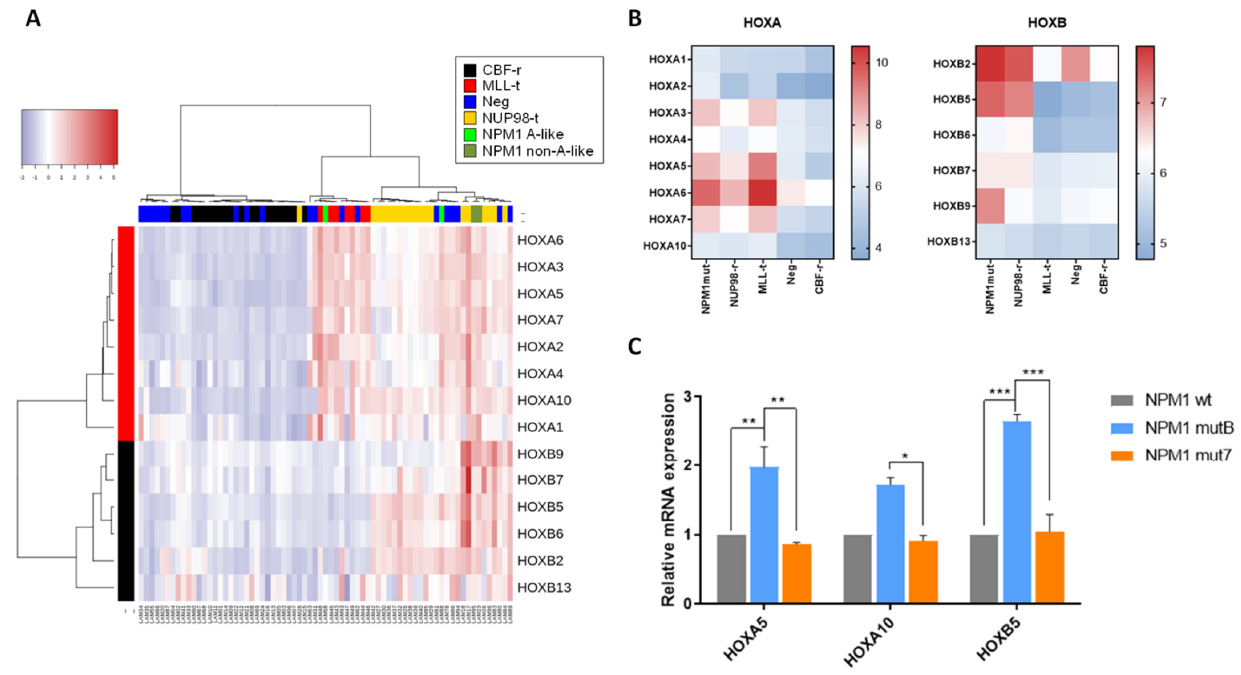
Figure 2. HOXA and HOXB gene expression according to NPM1 mutations. ( A ) Hierarchical clustering analyses of 71 AML patients for HOXA and HOXB family genes expression. AML genetic subtypes are reported in the legend with color codes. ( B ) Heatmap visualization of the median expression of HOXA and HOXB genes within the different AML genetic subtypes: NPM1 mutations n = 4, MLL translocations n = 7, NUP98 translocations n = 19, negative for tested molecular markers n = 21, CBF rearrangements n = 20. ( C ) mRNA expression levels of HOXA5, HOXA10 and HOXB5 in HL-60 cells transfected with pEGFP-NPM1wt, pEGFP-NPM1mutB (A-like), and pEGFP-NPM1mut7 (non-A-like), evaluated by RQ-PCR. Data are presented as mean of three independent experiments ± SEM. * p -value < 0.05, ** p -value < 0.01, *** p -value < 0.001.